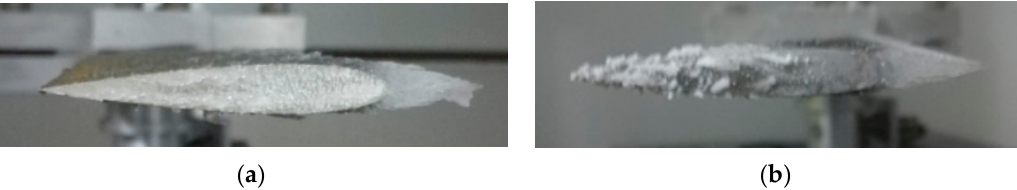
Figure 12. Ice shapes under different blade numbers: ( a ) case 1, four blades; ( b ) case 8, two blades.